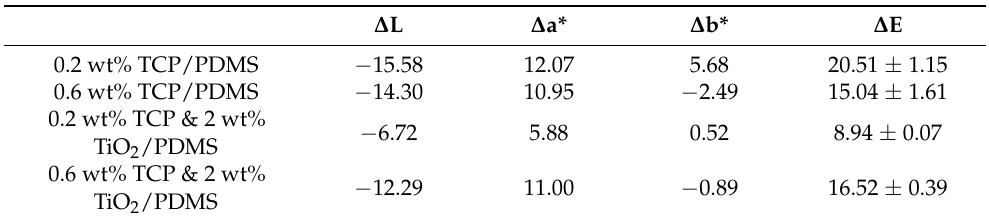
Figure 5. Color change of PDMS and 2 wt% TiO 2 /PDMS nanocomposite specimens colored with TCP (0.2 and 0.6 wt%), between room temperature (20 ◦ C) and specimens stored at − 20 and 40 ◦ C for 60 min. Table 6. Differences in color values ( ∆ L, ∆ a*, ∆ b* and ∆ E) between room temperature specimens and specimens stored at − 20 ◦ C for 60